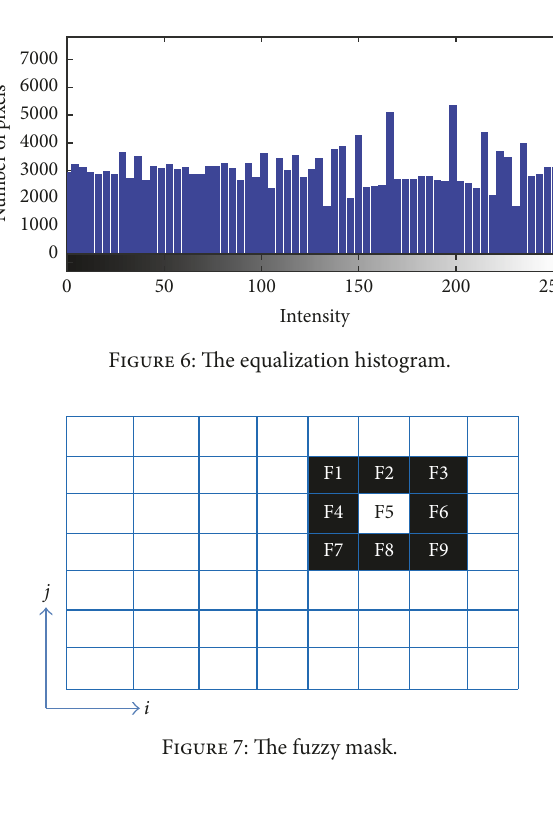
Figure 5: The histogram with min = 150 and max = 200.